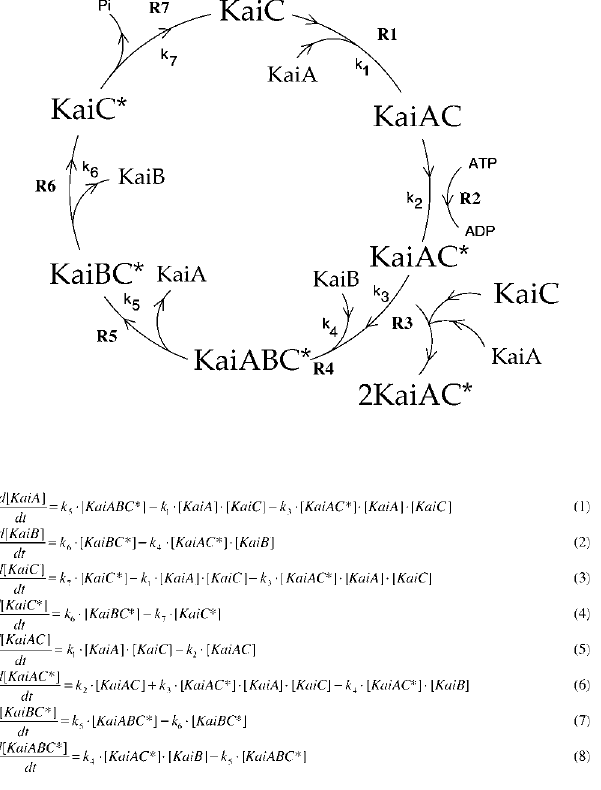
Figure 1. A Dynamical Model of In Vitro Rhythmic KaiC Phosphorylation See text for description. DOI: